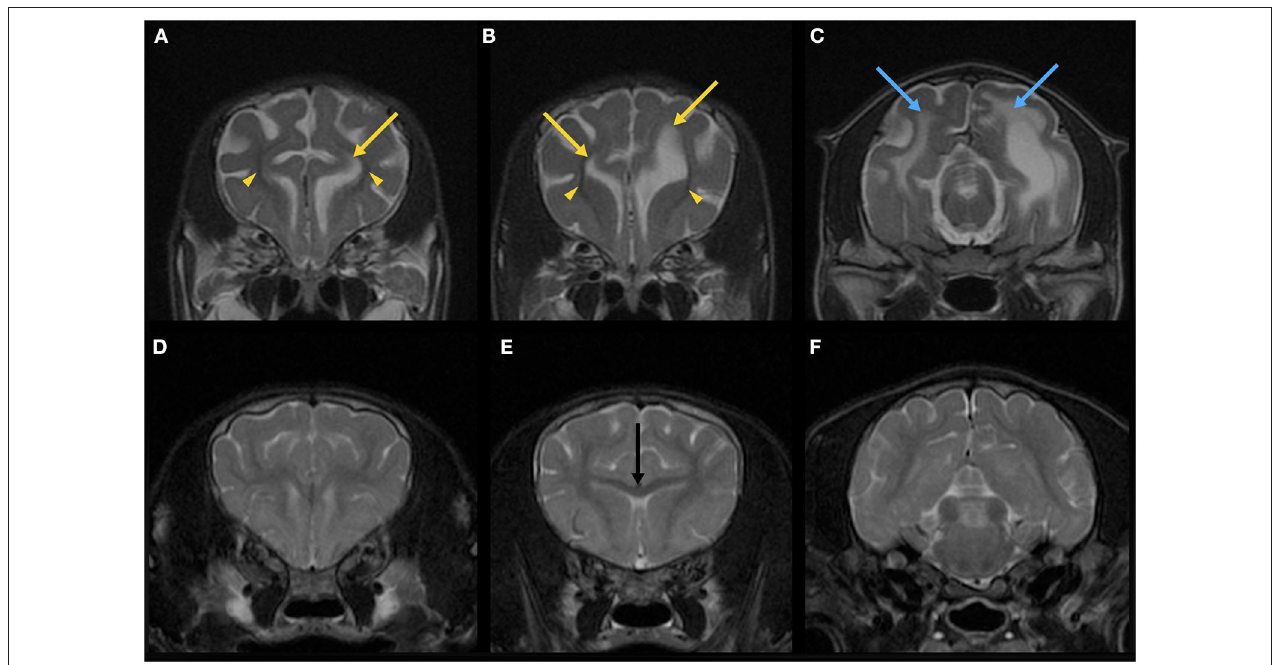
FIGURE 3 | Magnetic resonance T2-weighted imaging (T2WI) of the brain in the transverse plane of the patient (64-days-old) (A–C) and a normal beagle dog (73-days-old) as a similar-age reference (D–F) . On the T2WI at the levels of the frontal lobe of the patient (A,B) , the lateral ventricles seemed to have upturned pointed corners (yellow arrows). Marked hypoplasia of subcortical white matter is also seen (yellow arrowheads). The brain sulci are clearly visible due to the suspected developmental abnormality. On the T2WI at the level of the occipital lobe of the patient (C) , there are T2-hyperintense lesions (blue arrows) in the right and left white matter in addition to the dilated left lateral ventricle. Corpus callosum ( E , black arrow) is clearly seen in a 73-days-old normal beagle dog (E) , but not in the patient (B)